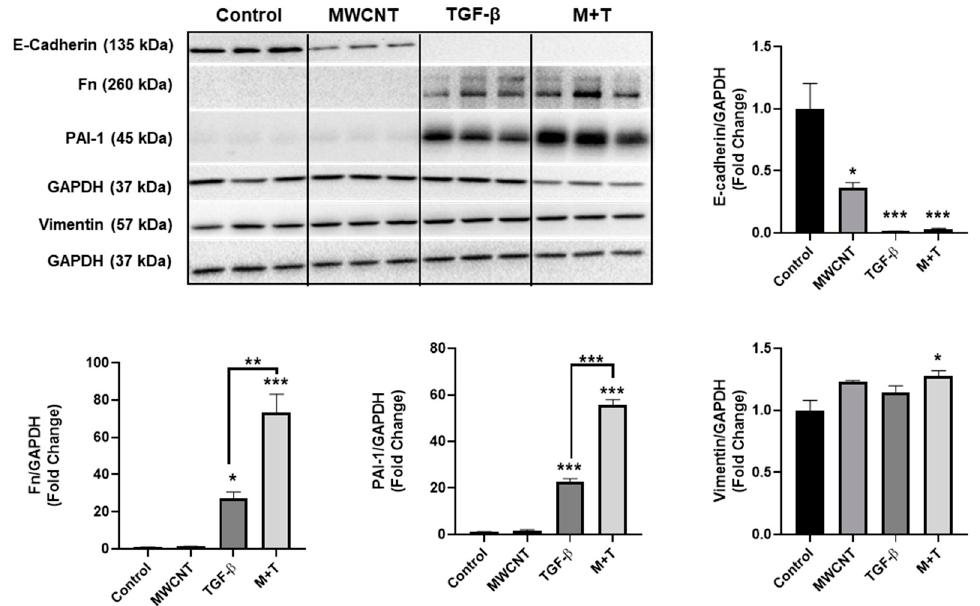
Figure 3. MWCNT and TGF- β induce EMT and increase ECM production. BEAS-2B were exposed to MWCNT (5 µ g/mL) and/or TGF- β (5 ng/mL) for 72 h. ECM protein markers were assessed by immunoblot. Data are shown as fold change relative to control; data are shown as mean ± SEM ( n = 3/group) * p < 0.05, ** p < 0.01, *** p < 0.001 indicates significance. M+T: Combined MWCNT and TGF- β treatment. An equal volume of DPPC was added to control.